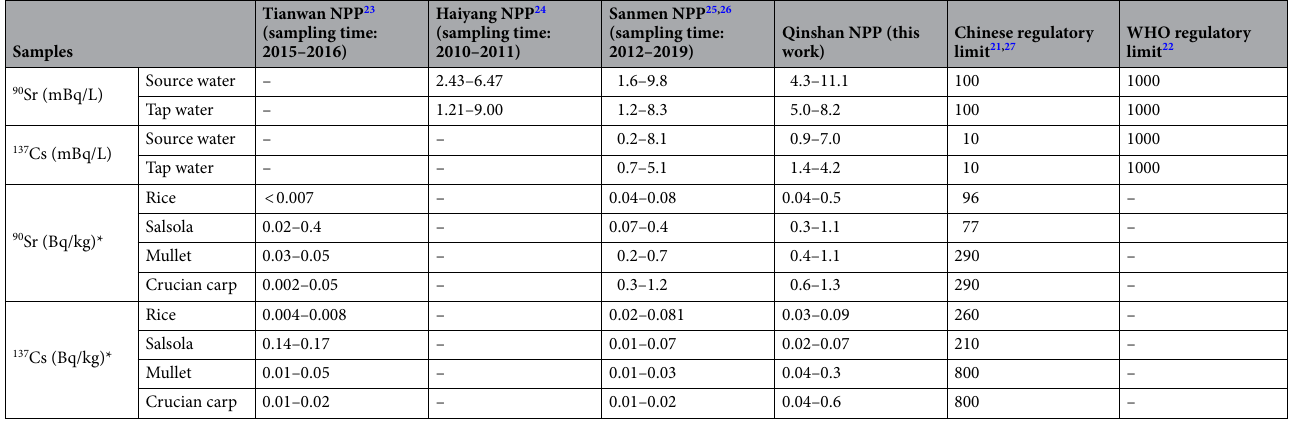
Table 2. Activity concentrations of 90 Sr and 137 Cs in water and food samples collected around NPPs in various regions of China. – means there was no relevant data. *Results for food samples were given as Bq/kg fresh weight.